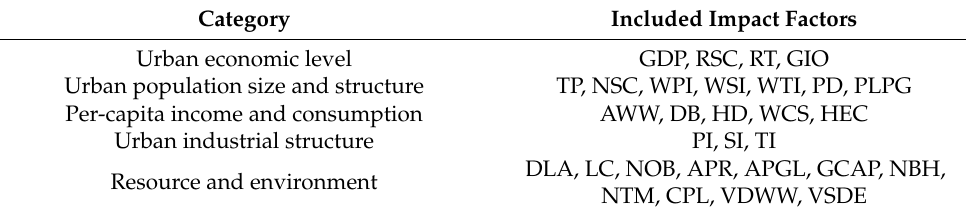
Table 2. The extraction result of significant impact factors.